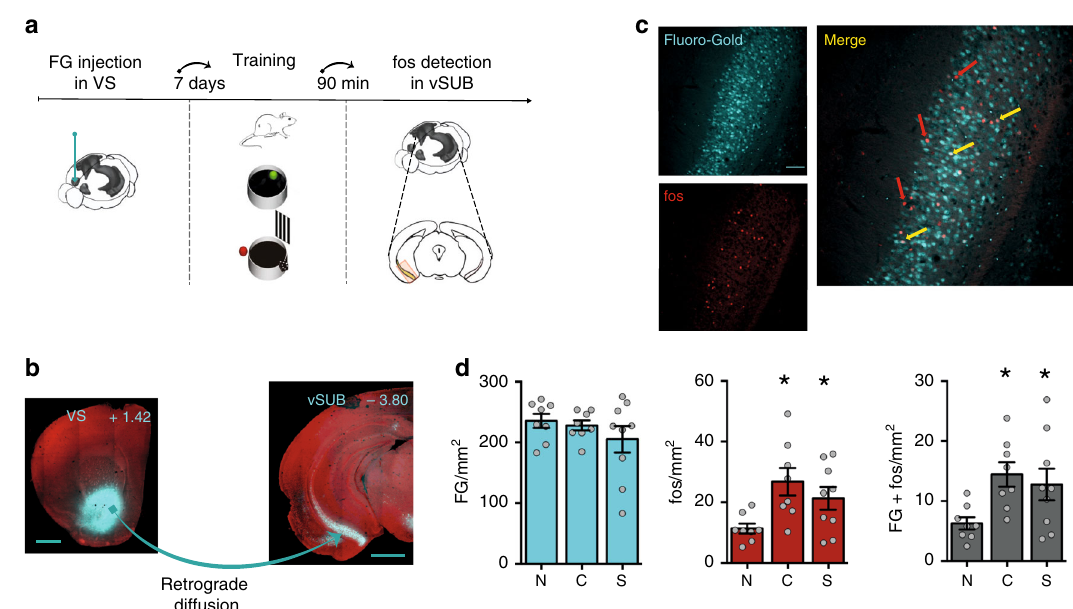
Fig. 1 vSUB projection to the VS is activated by training in the water maze. a Schematic of the experimental design. Retrograde tracer Fluoro-Gold (FG) combined with fos was used to identify subicular VS-projecting cells activated by cue or spatial training in the MWM. MWM images modi fi ed from ref. 9 ; Image credit for brains schematics: Allen Institute. b Microphotographs showing FG injection site in the VS and VS projecting cells in the vSUB (cyan). Images are counterstained with the nuclear dye propidium iodide (red). Scale bar: 1 mm; coordinates from bregma (mm). c Representative images showing FG, fos labeling and the overlay of the two labeling in the vSUB (red arrows: fos; yellow arrows: co-labeling). Scale bar: 100 µ m. d fos expression was signi fi cantly increased in the whole vSUB ( F 2,22 = 4.762, p = 0.0191), as well as in the subicular VS-projecting cells ( F 2,22 = 4.178, p = 0.0290), in both cue (C; n = 8) and spatial (S; n = 9) trained mice compared to naïve (N = naïve to training; n = 8). No difference was found among groups in the number of FG- positive cells ( F 2,22 = 1.023, p = 0.3762). Histograms represent mean ± SEM. * p < 0.05 vs naïve